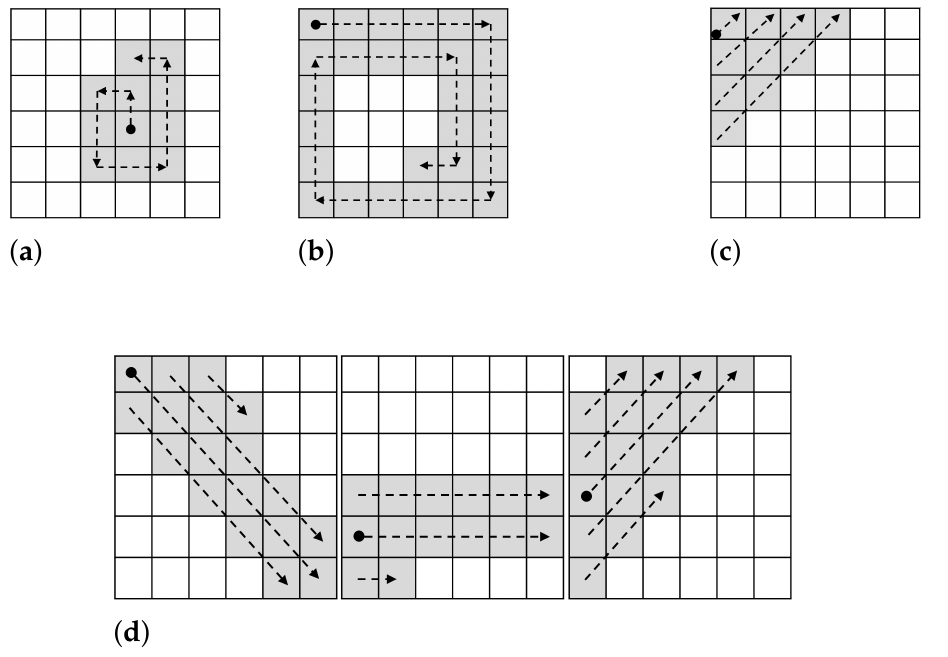
Figure 6. Filling strategies. ( a ) Counterclockwise (CCW); ( b ) Clockwise (CW); ( c ) Diagonal (Diag); ( d ) Strokes (Strk).